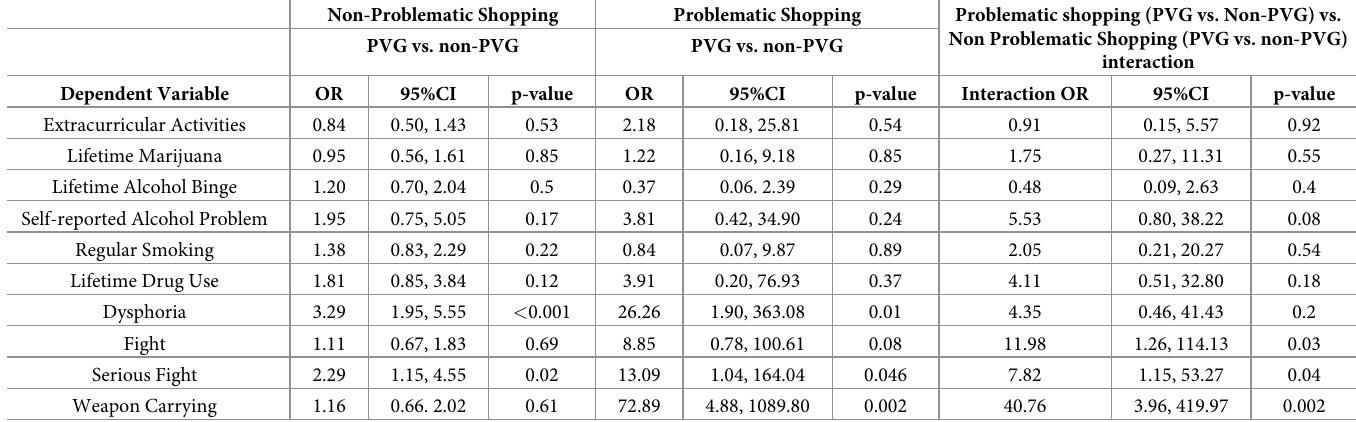
Table 6. Adjusted Multivariate analyses of PVG on health/functioning measures stratified by problematic-shopping